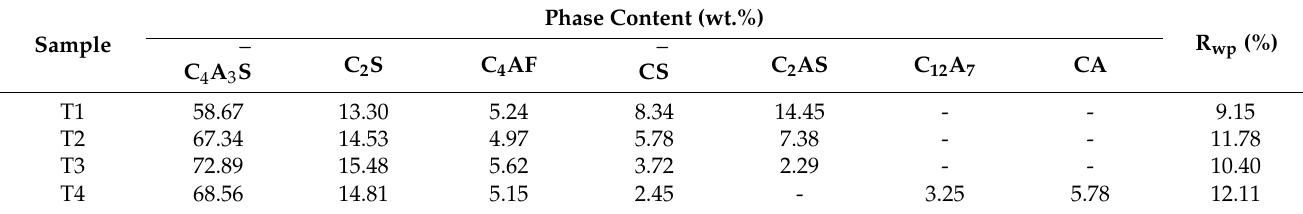
The compressive strength of CAS at different calcination temperatures is shown in Figure 10. When the calcination temperature is increased from 1150 to 1250 ◦ C, the com- pressive strength of the cement shows an increasing trend with increasing calcination temperature. In contrast, when the calcination temperature rises to 1300 ◦ C, the cement’s compressive strength decreases slightly, which is related to the clinker’s mineral composi- tion. The cement compressive strength is in good agreement with the XRD analysis, and the calcination temperature of 1250 ◦ C was chosen for the firing of the clinker.